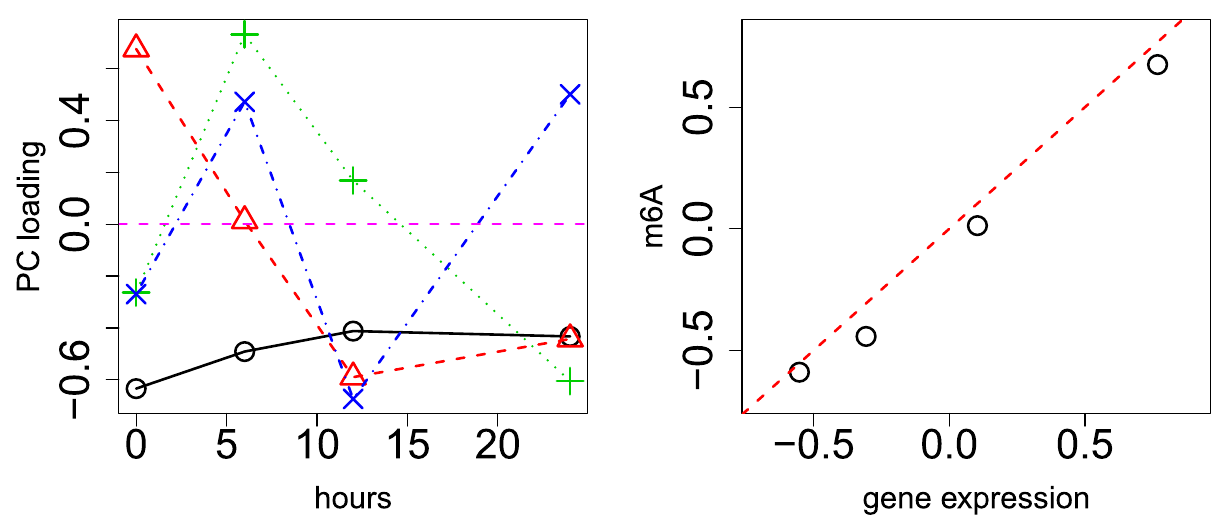
Figure 3. Left: Singular value vector, u ℓ 2 t , computed by HOSVD applied to time points with applying HOSVD to m6A profiles. Open black circles: 1st (0.78). Open red triangles: 2nd (− 0.80), green crosses: 3rd (− 0.47), blue crosses: 4th PC loading (0.36). The numbers in parentheses are the Pearson’s correlation coefficients. Hours (horizontal axis) represent the duration after the treatments. Horizontal magenta broken line indicates baseline (zero). Right: scatter plot between v 2 t , which is the 2nd PC loading attributed to time points when PCA was applied to x it , (horizontal axis) and u 2 t (vertical axis). The red broken line indicates v 2 t = u 2 t .